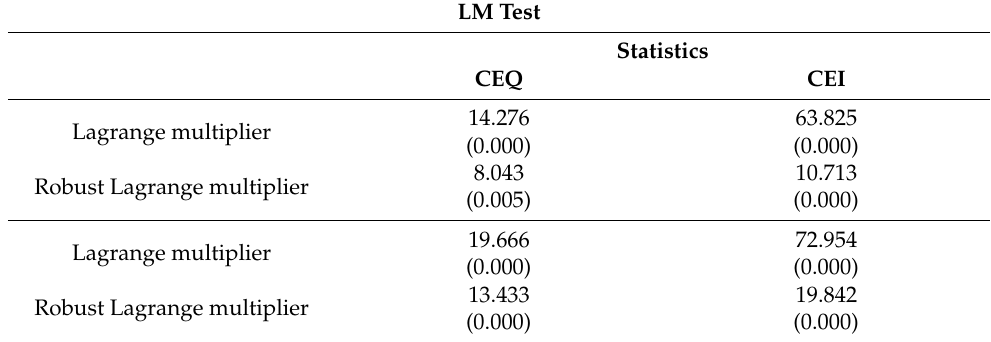
Table 7. LM test results.